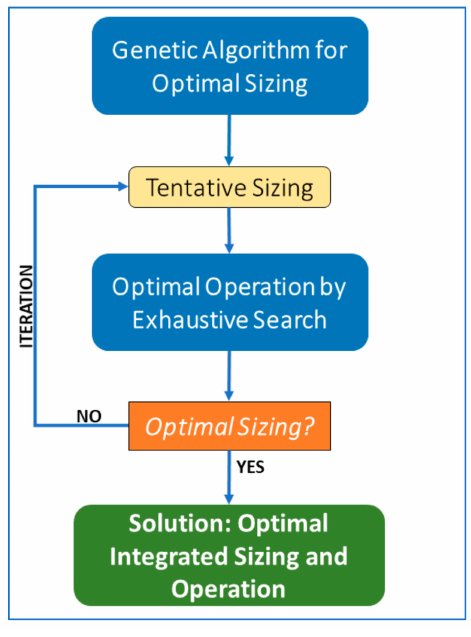
Figure 4. Optimization procedure.